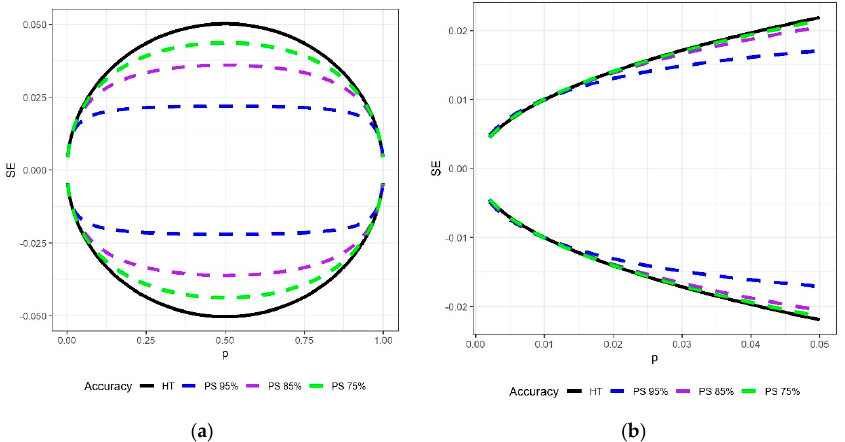
Figure 10. ( a ) Proportions (p) of change on the landscape and the expected standard errors using a Horvitz–Thompson estimator (black solid line) versus those using a post-stratified estimator, with change / no-change strata at varying map accuracies. Errors of omission in a no-change stratum are fixed at 95%. Accuracies within the change stratum are fixed at 95% (blue), 85% (green), and 75% (purple). ( b ) The same as ( a ) but zoomed in on small